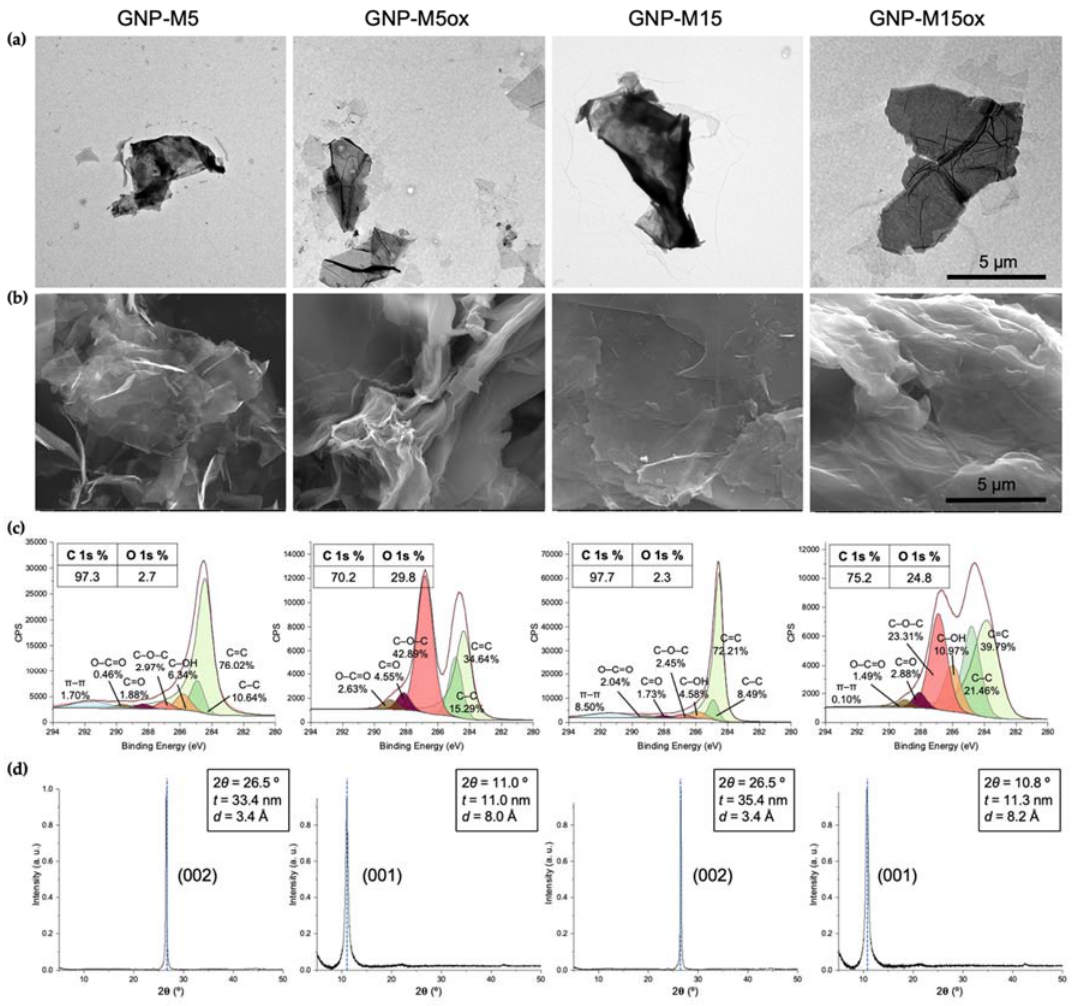
Figure 1. Characterization of graphene nanoplatelet (GNP) powders (GNP-M5, GNP-M5ox, GNP-M15 and GNP-M15ox): ( a ) TEM images (first row) and ( b ) SEM (second row) images (scale bar = 5 µ m), ( c ) XPS atomic composition and carbon high-resolution spectra with respective functional groups, and ( d ) XRD patterns with di ff raction angle (2 θ ), thickness ( t ) and interlayer spacing between sheets ( d ).